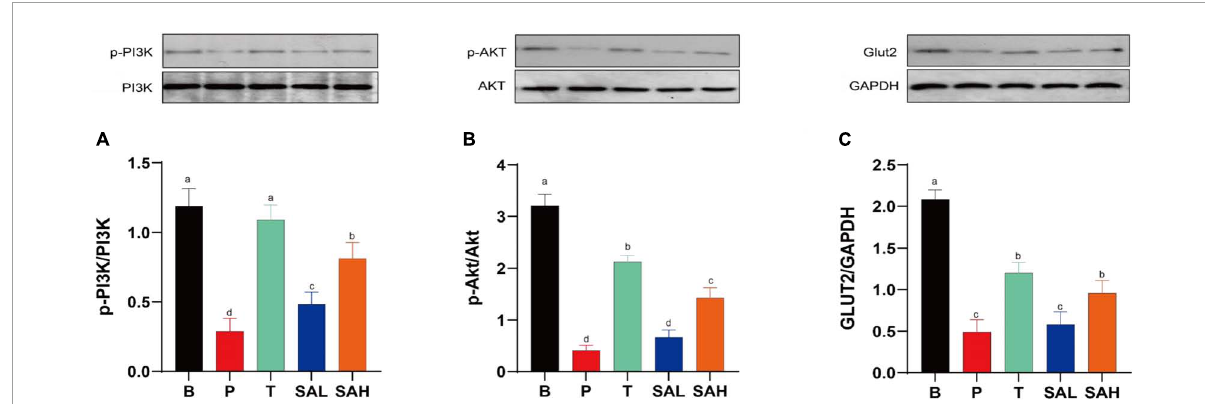
FIGURE5 Sciadonic acid (SA) improved type 2 diabetes mellitus (T2DM) by activating the hepatic PI3K/AKT/GLUT-2 signaling pathway. (A) p-PI3K/PI3K, (B) p-AKT/AKT, and (C) GLUT-2/GAPDH. Data are presented as the mean ± SD of three experiments. Different letters represent a significant difference among multiple groups ( P < 0.05). B, control group; P, diabetic model group; T, (HFD + 200 mg kg – 1 Met); SAL, (HFD + 70 mg kg – 1 SA); SAH, (HFD + 280 mg kg – 1